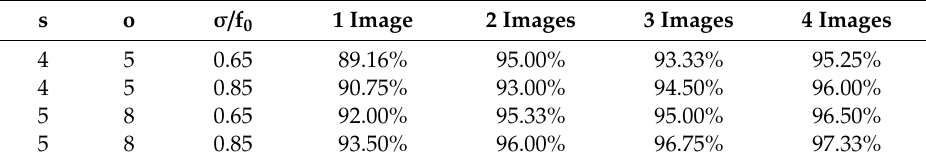
Figure 8. Cumulative match characteristic (CMC) curve for the Iris unimodal biometric system performed on the Chinese academy of sciences institute of automation (CASIA) database. Table 2. Recognition rate of the iris unimodal biometric system performed on the CASIA